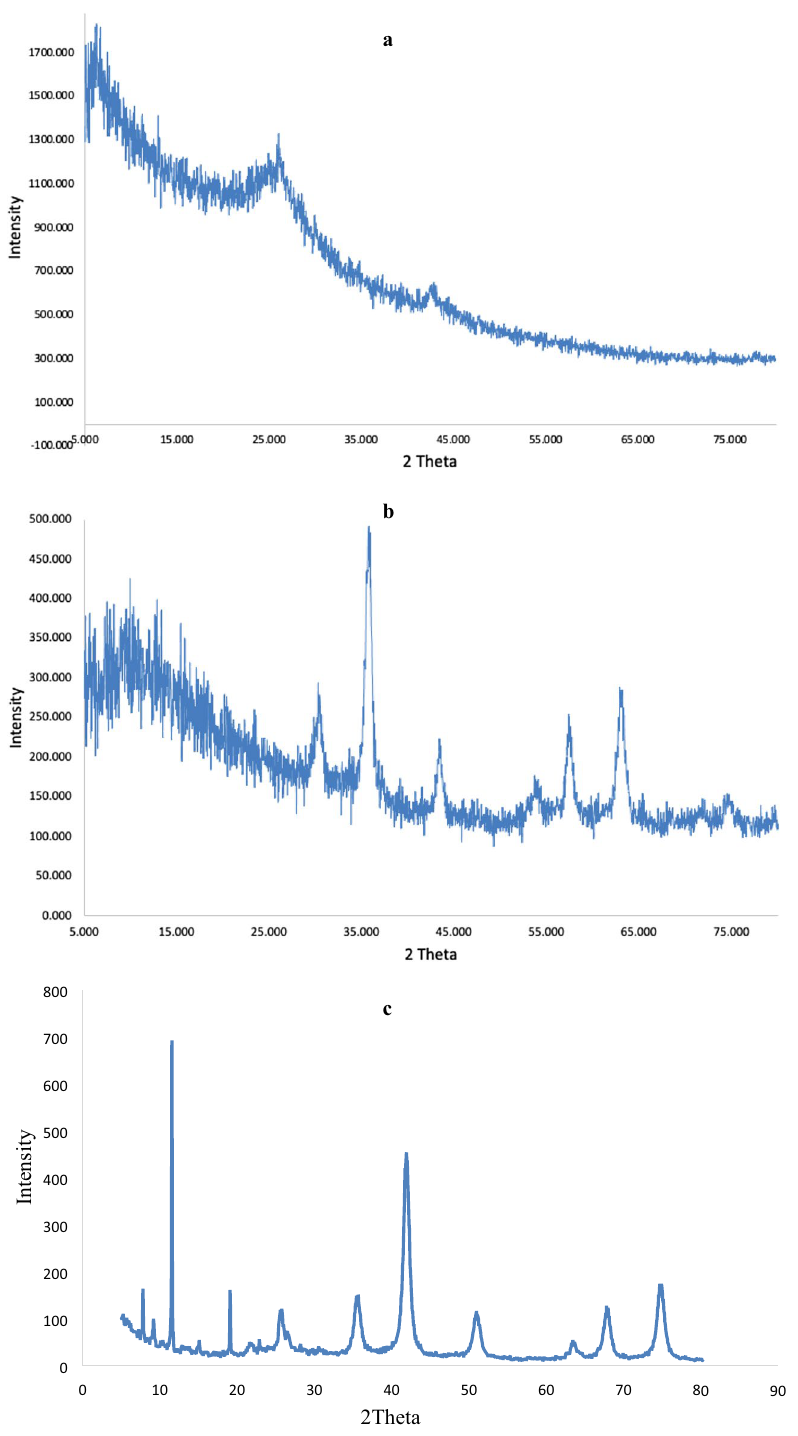
Figure 4. XRD pattern of ( a ) GO, ( b ) GF and ( C ) GFLE